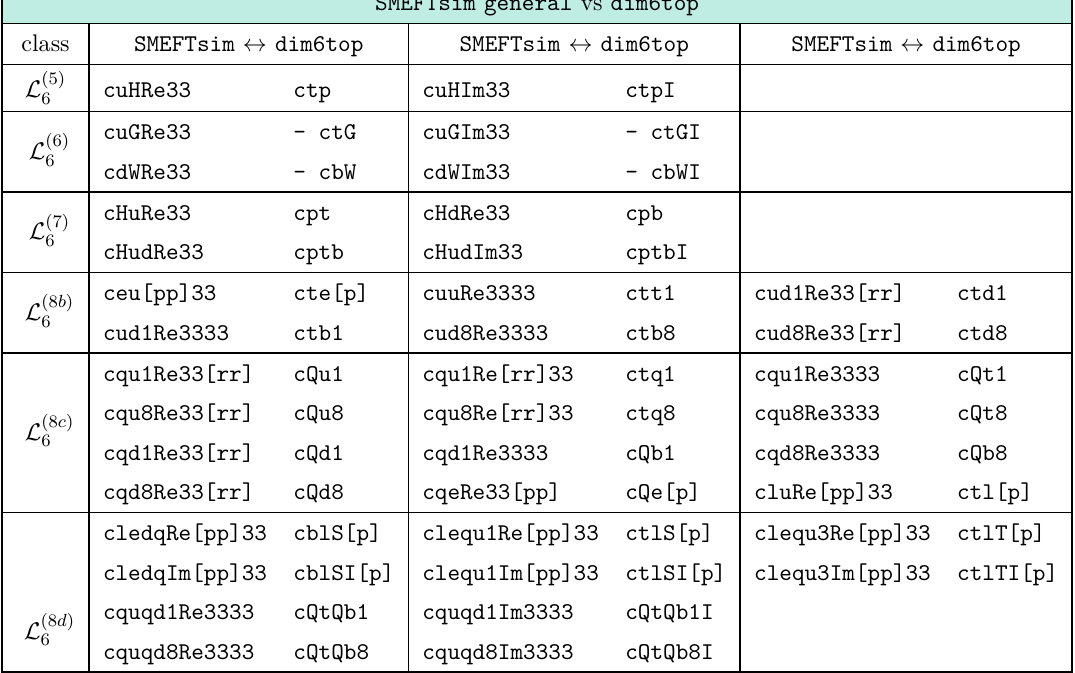
Table 26 . Conversion table between the SMEFT parameters defined in the general version of SMEFTsim and in dim6top : parameters with one-to-one conversion. Lepton flavor indices p take values in { 1,2,3 } . Quark flavor indices r take values in { 1,2 }